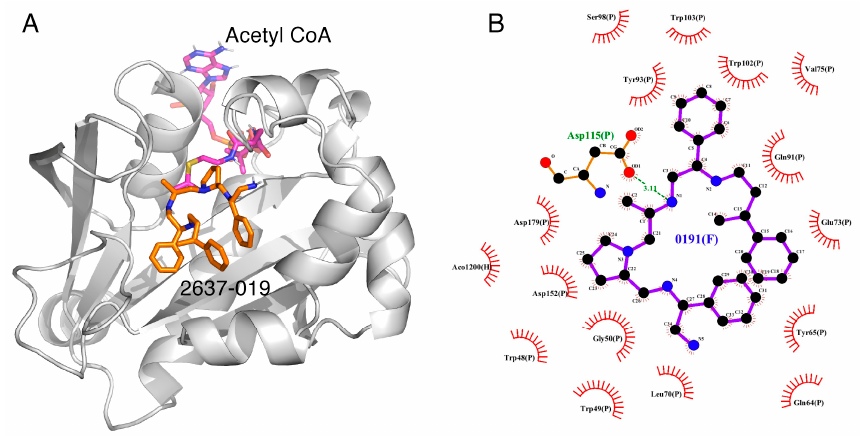
Figure 4. ( A ) The complex of 2637.019 and AAC(6 (cid:48) )-Ib obtained from molecular docking. The bound actyl CoA is also shown. The figure shows a potential for intramolecular pi stacking between the R1 and R5 phenyl groups. ( B ) Interaction map of the ligand in its binding site of the AAC(6 (cid:48) )-Ib receptor. Compound 2637.019 still maintains a hydrogen bond interaction with Asp115. The pictures show the top-ranked, lowest-energy